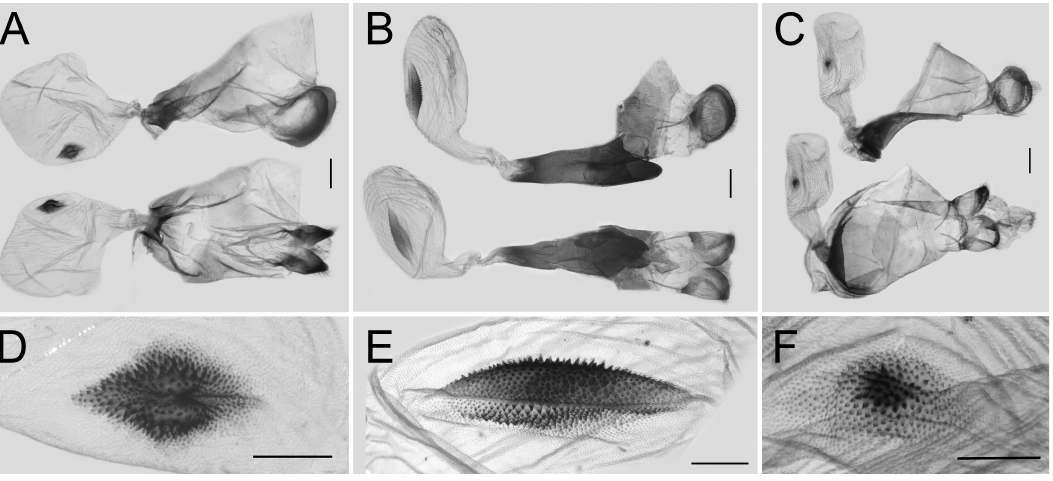
Figure 8. Female genitalia of Losaria rhodifer ( A ), L. neptunus ( B ), and L. palu ( C ), scale bars = 1.0 mm; with enlarged signum ( D – F ), scale bars = 0.5